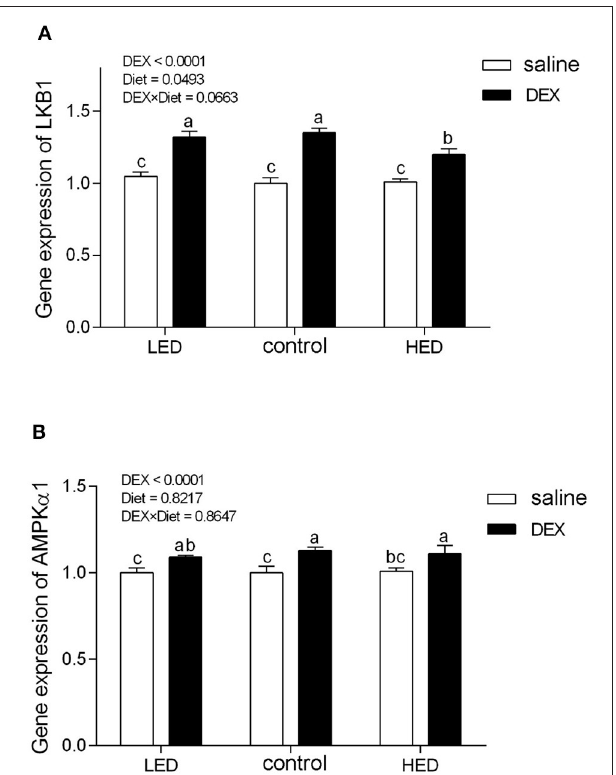
FIGURE 1 | Effects of DEX on the mRNA expression levels of LKB1 (A) and AMPK α 1 (B) in the hypothalamus of 13-day-old broilers fed with different energy level diets. Values were obtained from duplicates of each sample and are presented as mean ± SEM ( N = 8); a,b,c Means sharing no common letters differ significantly ( P < 0.05; ANOVA). LED, low energy diet; control, National Research Council-recommended diet; HED, high energy diet; DEX, dexamethasone.